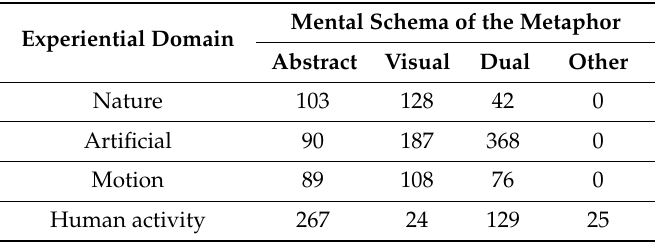
Table 2. Experiential domains and mental